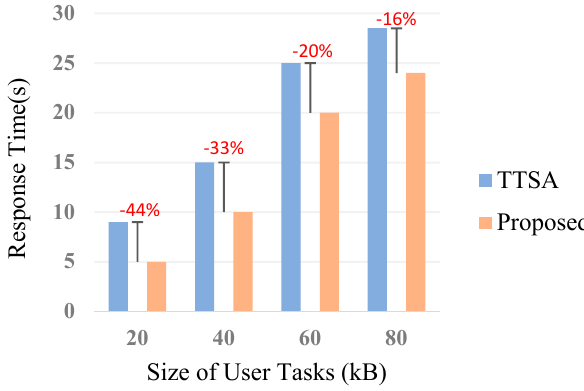
Figure 5. Comparison of response time.